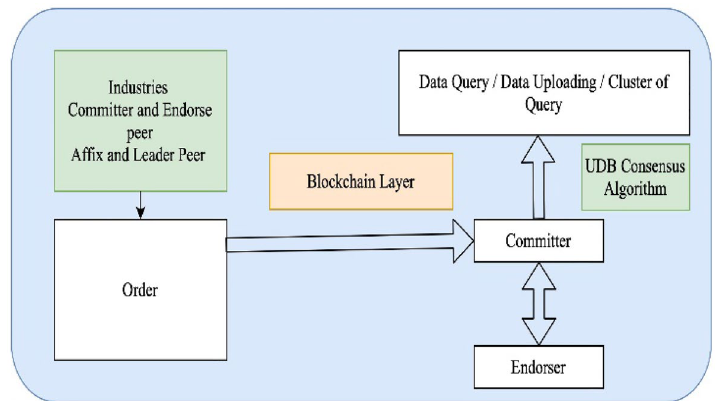
Figure 6. Blockchain consensus layer with